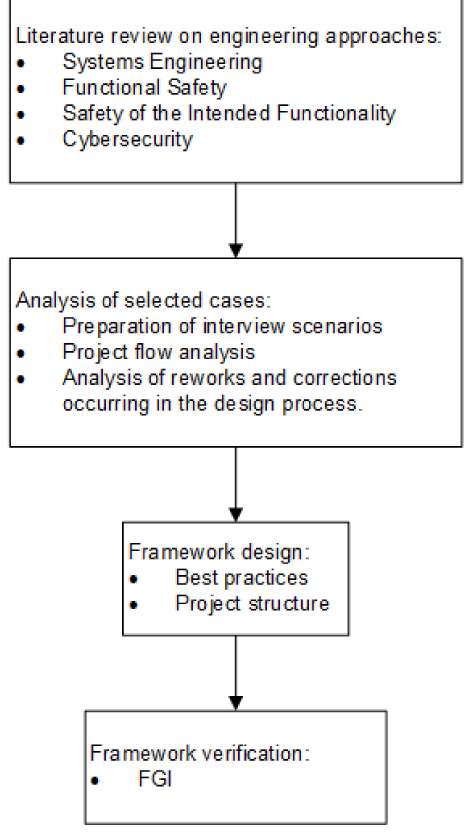
Figure 4. Research